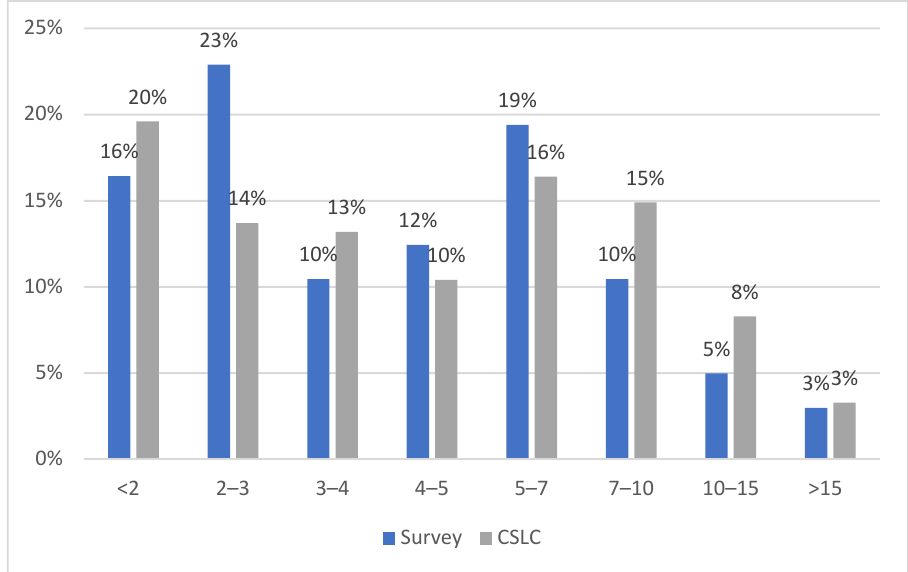
Figure 3. Distribution by income class (comparison of our survey data and Comprehensive Survey of Living Conditions (CSLC)).